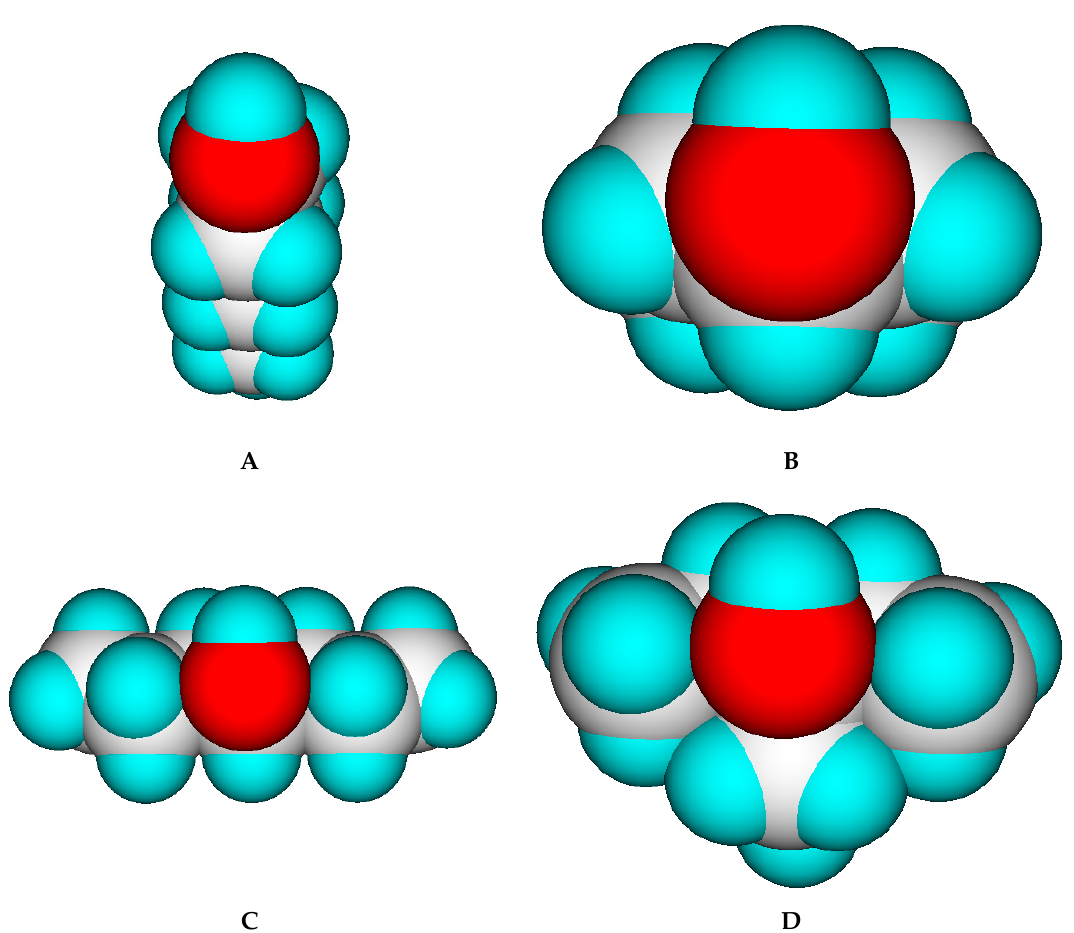
Figure 10. Top view of energy-minimized forms of four C7 alcohols (graphics by ChemBrain IXL). ( A ): 1-heptanol. ( B ): 4-methylcyclohexanol, ( C ): 4-heptanol. ( D ): 3-ethyl-3-pentanol.